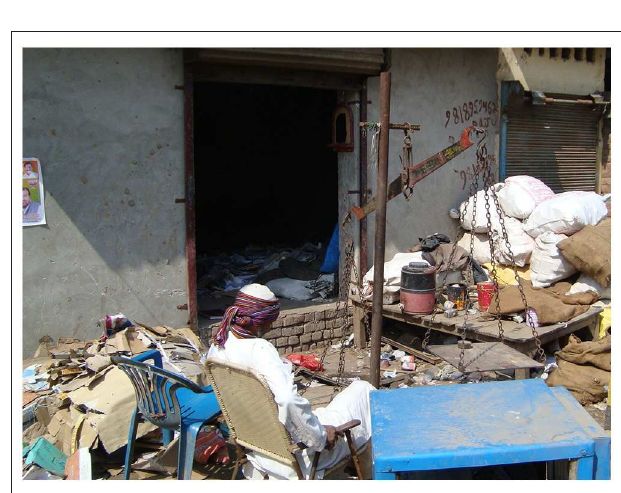
FIGURE 8 | Scrap dealers buy recyclables from the waste pickers and sell them on through the recycling